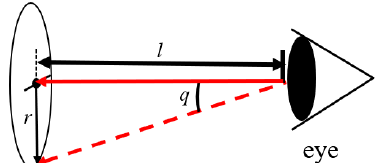
Figure 3. Control screen designed by Kogawa et al. [43].